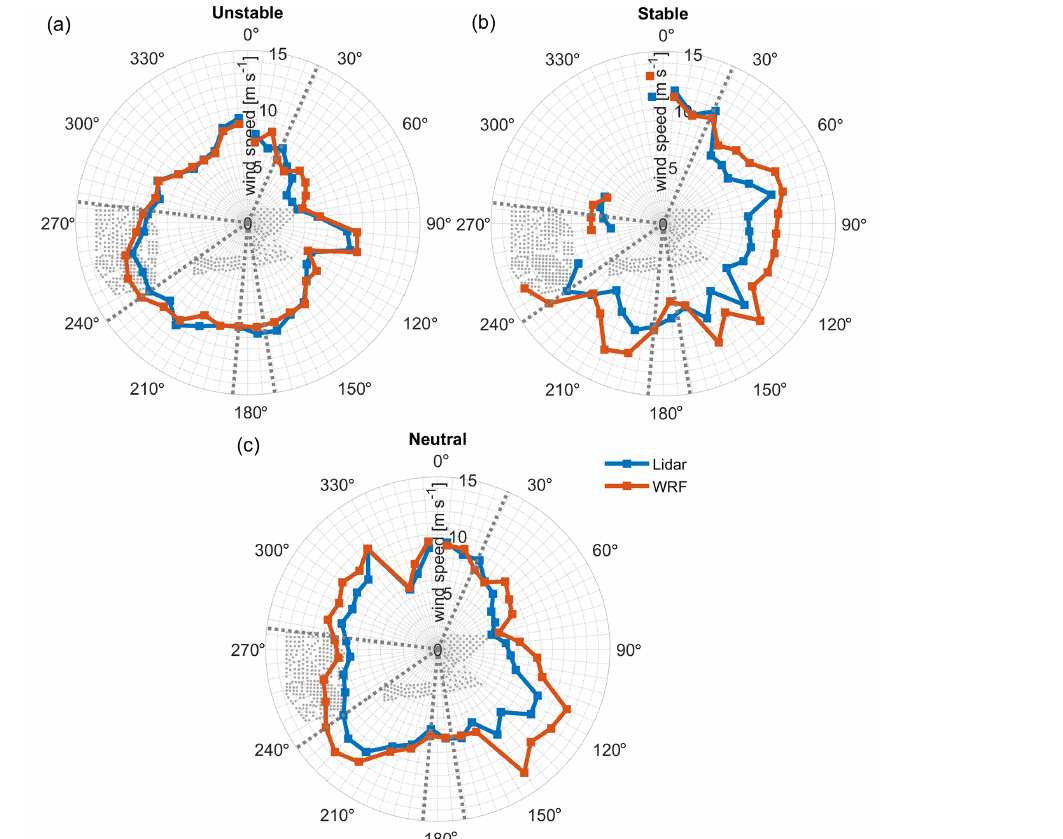
Figure 12. Wind speed polar plots of the lidar measurements and WRF results (without the wind farm parameterization) for (a) unstable, (b) stable and (c) and neutral atmospheric stratification at the height of 120m. Wind turbines are indicated by gray points and the regions R1–5 by dashed gray